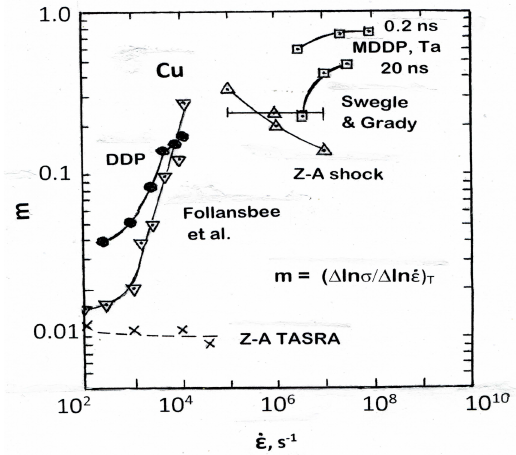
Figure 4. Computed strain rate sensitivity, m = [ ∆ ln σ / ∆ ln(d ε /dt)] T , measurements and calcu- lations for copper and tantalum materials covering a range of strain rates from SHPB to shock deformations